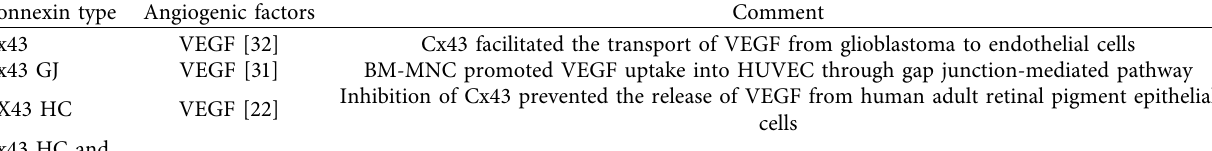
Table 1: Effect of Cx43 on angiogenic